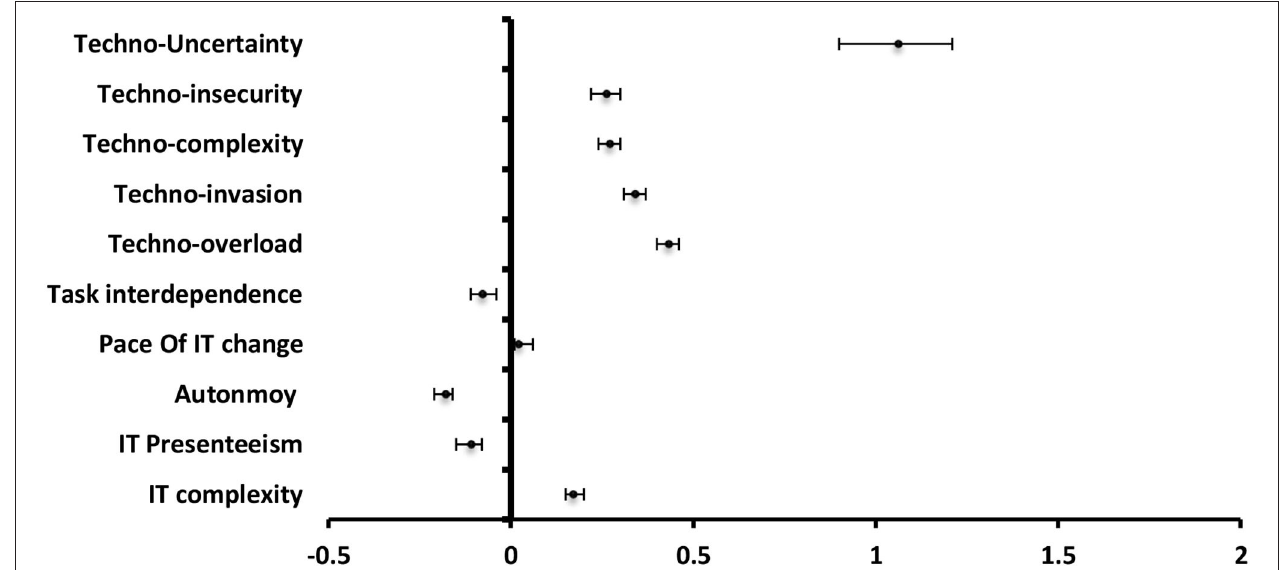
FIGURE 6 | Values of β and CI 95% for linear regression analysis of techno-stress items and job and technology characteristics as a predictor to burnout among students.